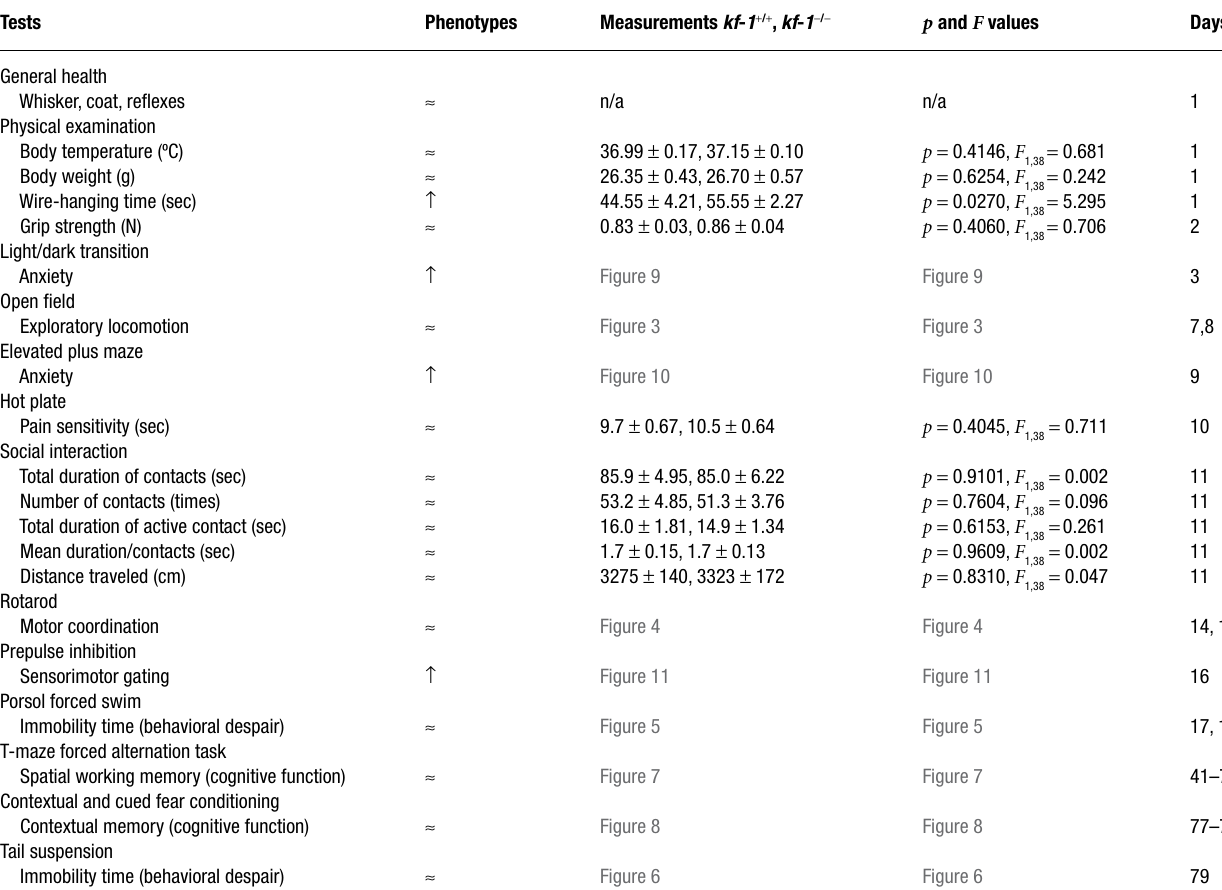
Table 1 | Comprehensive behavioral test battery and phenotypes of kf-1 −/−−/−